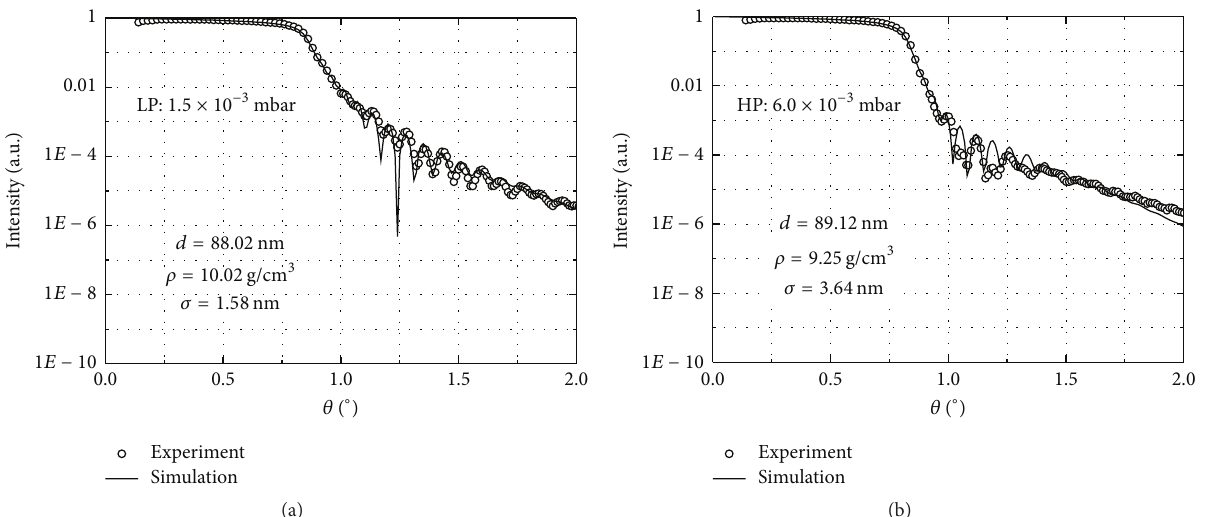
Figure 2: XRR measurements of single-layer Mo films of thickness ∼ 90 nm deposited at (a) low pressure ( 1.5 × 10 −3 mbar) and (b) high pressure ( 6 × 10 −3